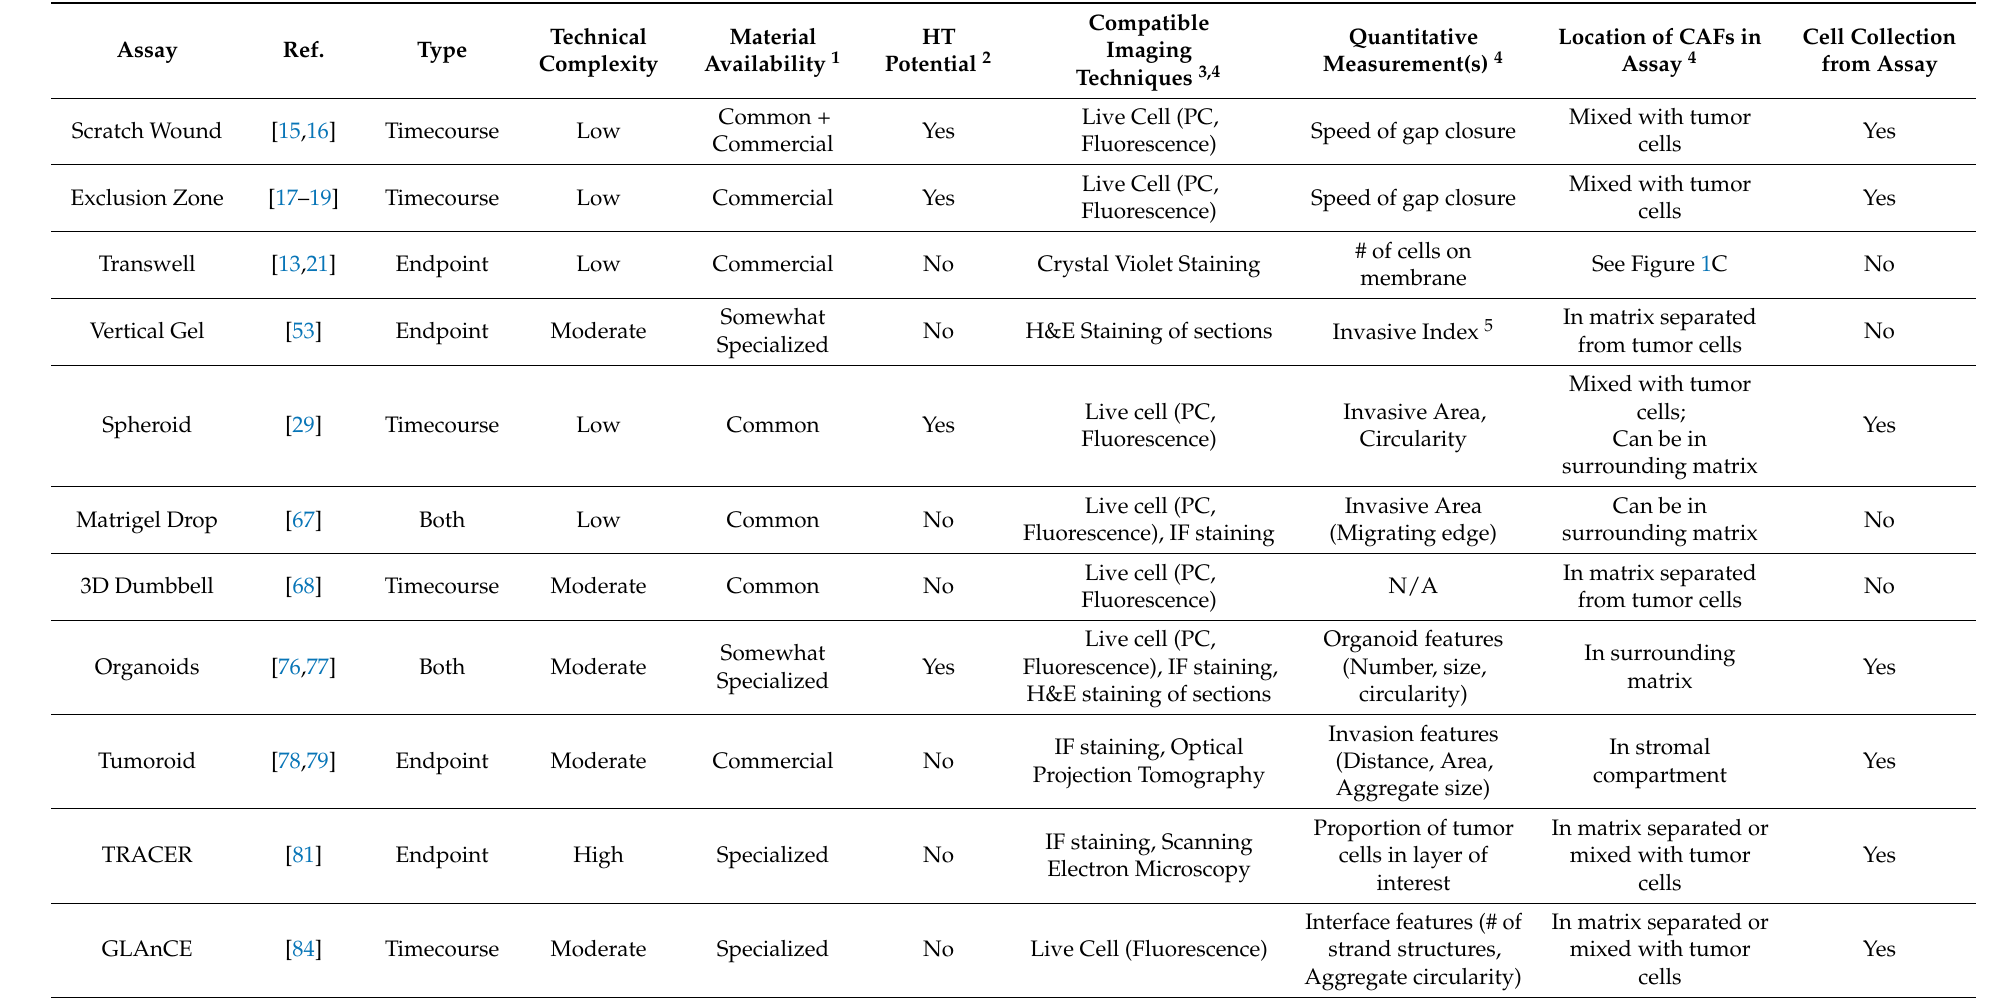
Table 1. Summary of all the assays along with key experimental